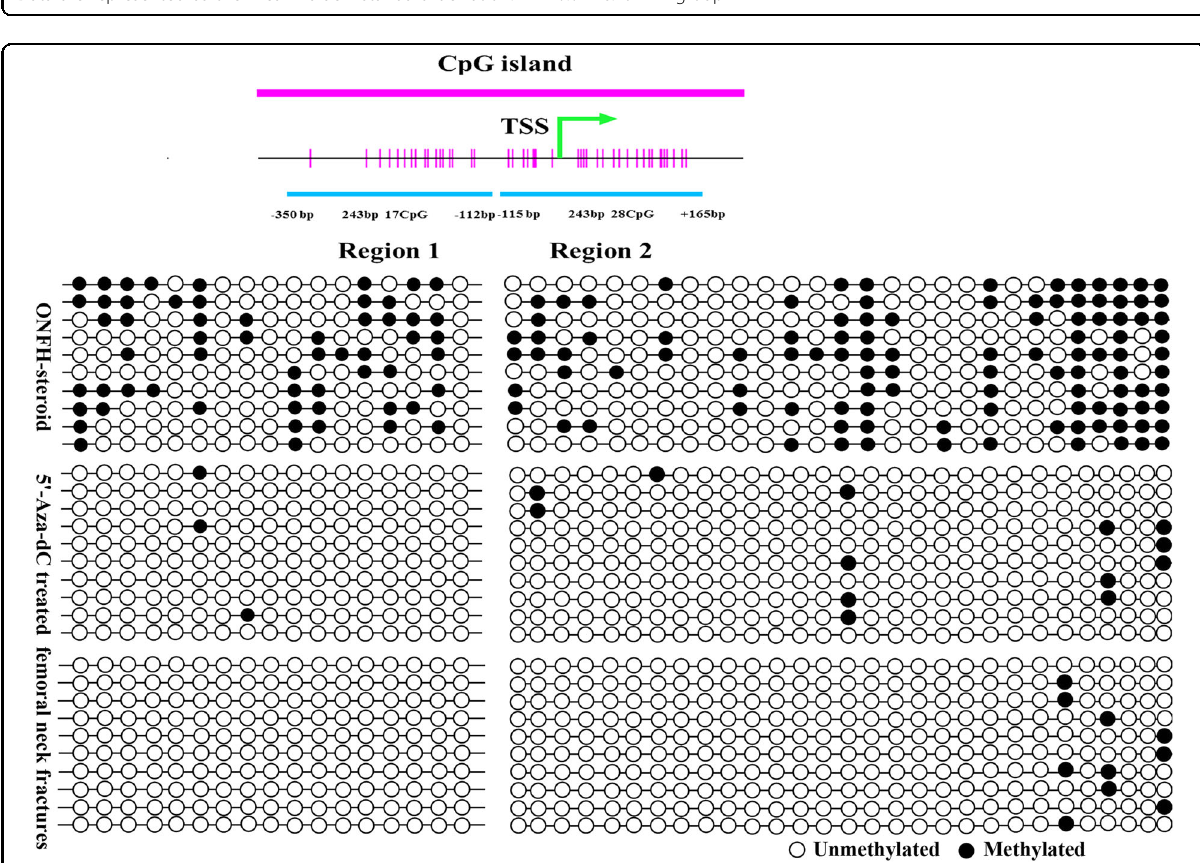
Fig. 5 Real-time PCR. The transcript levels of osteogenesis, adipogenesis and Wnt/ β -catenin signaling pathway-related genes in the three groups.